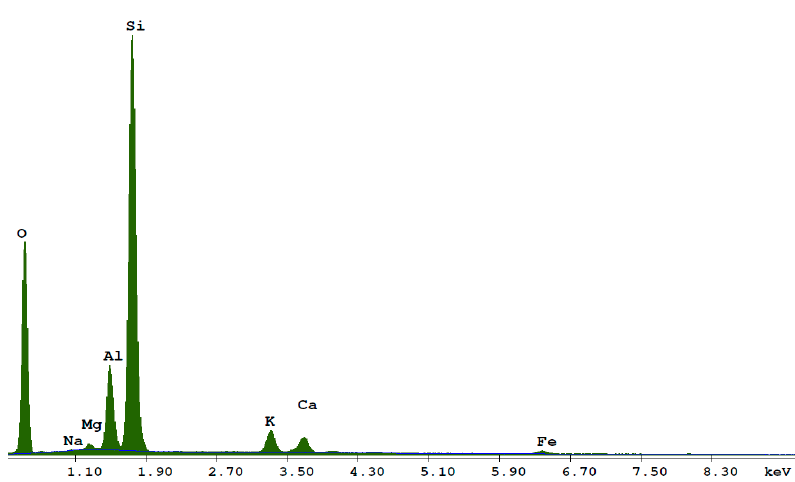
Figure 5. The EDX spectrum of the investigated zeolite sample. Table 4. The results of EDX analysis using standardless ZAF quantification method of the natural zeolite using the Quanta FEG 250 SEM.